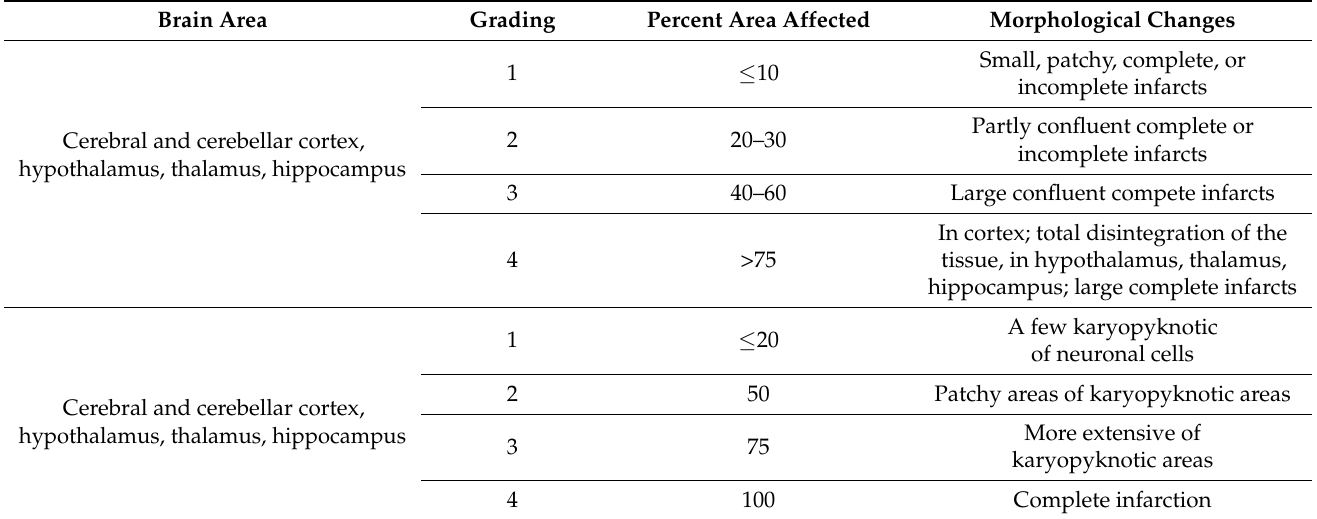
Table 1. The neuropathological